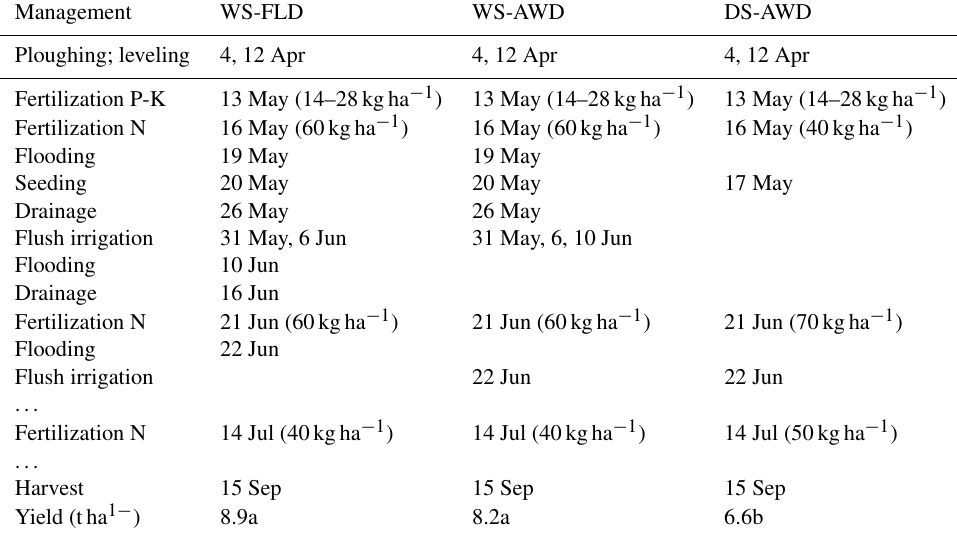
Table 1. Dates of management activities during the experimental period in the three water management treatments (WS-FLD: water- seeding + conventional flooding; WS-AWD: water-seeding + alternate wetting and drying; DS-AWD: direct dry seeding + alternate wetting and